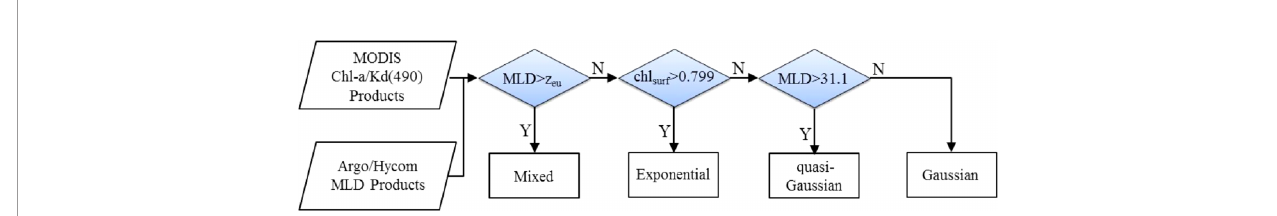
FIGURE 5 | Flowchart of the Chl-a vertical pro fi le classi fi cation model for the Mediterranean Sea.